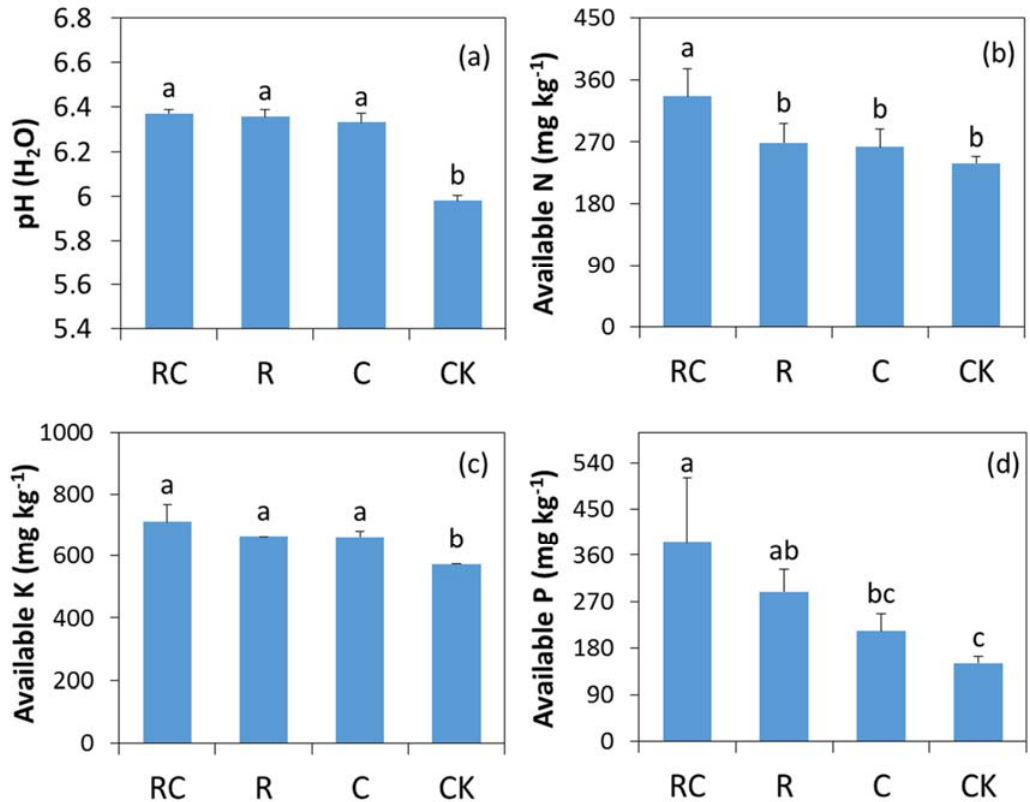
Figure 1. Soil pH ( a ), available N ( b ), available K ( c ) and available P ( d ) under mixed rice straw and biochar addition (RC), rice straw addition (R), biochar addition (C) and in control (CK) conditions. Values are the means of three replicates ( ± SE). Different letters indicate significant differences among the means of the different treatments.